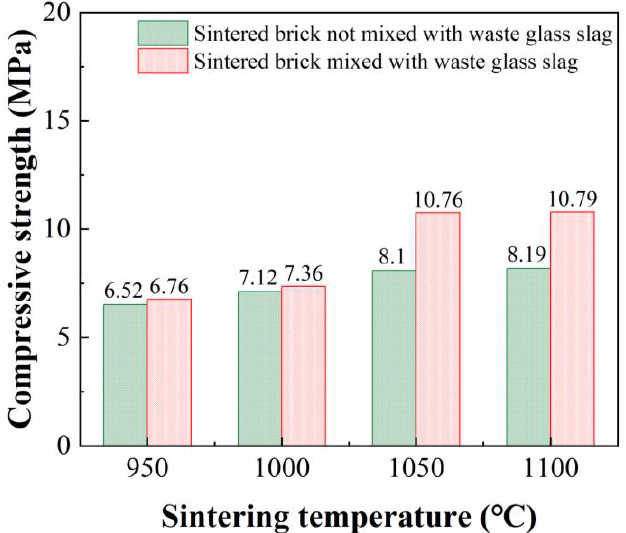
Figure 4. Effect of sintering temperature on the compressive strength of the MGB sintered